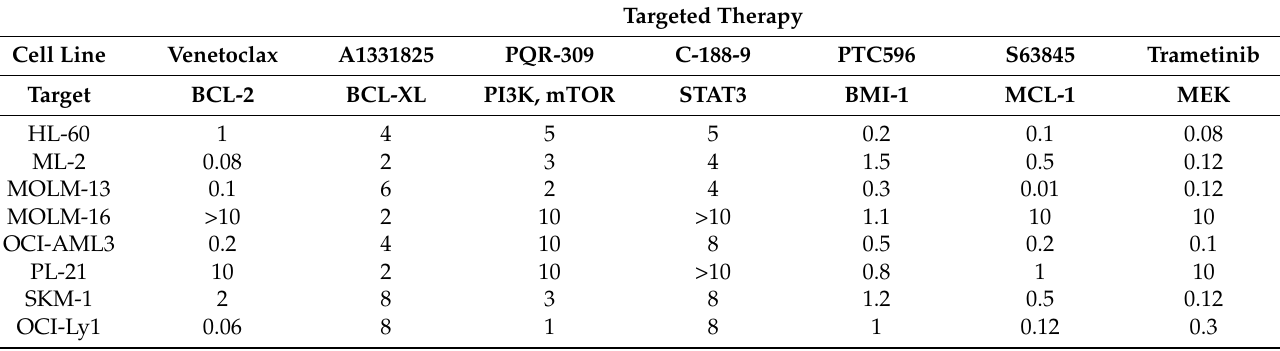
Table 2. IC50 values cell lines ( µ